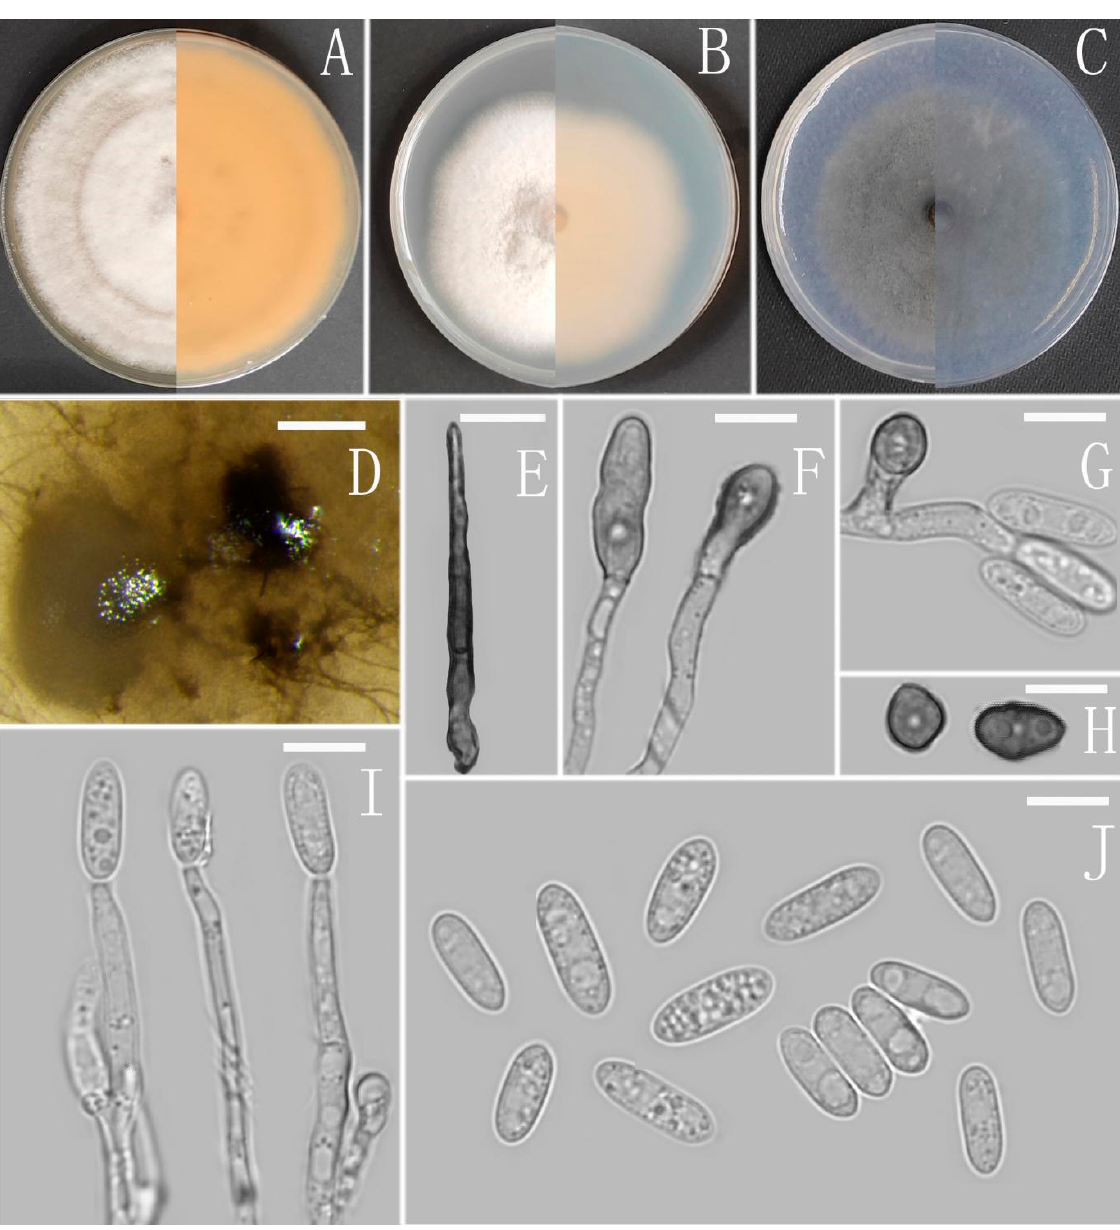
Figure 12. Colletotrichum simulanticitri (YMF1.07302). ( A – C ) Colonies on media above and below after 7 days at 25 °C (( A ) MEA; ( B ) PDA; ( C ) SNA). ( D ) Conidiomata. ( E ) Setae. ( F ), ( H ) Appressoria. ( G ) Appressoria and Conidia. ( I ) Conidiophores. ( J ) Conidia. Scale bars: ( D ) = 100 μ m, ( E – J ) = 10 μ m.